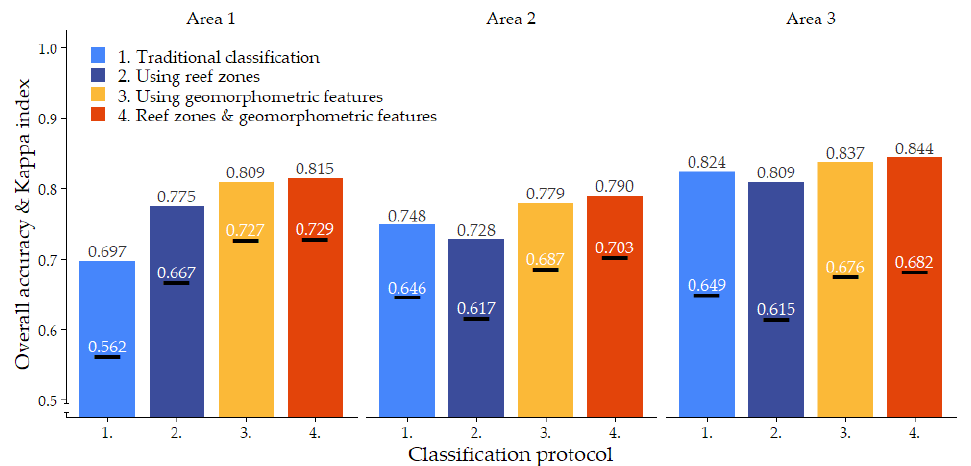
Figure 6. Overall accuracies (coloured bars and black numbers) and corresponding Cohen’s Kappa indices (black dashes and white numbers) of the four classification protocols split by survey area (Figure 1, and Table 2).